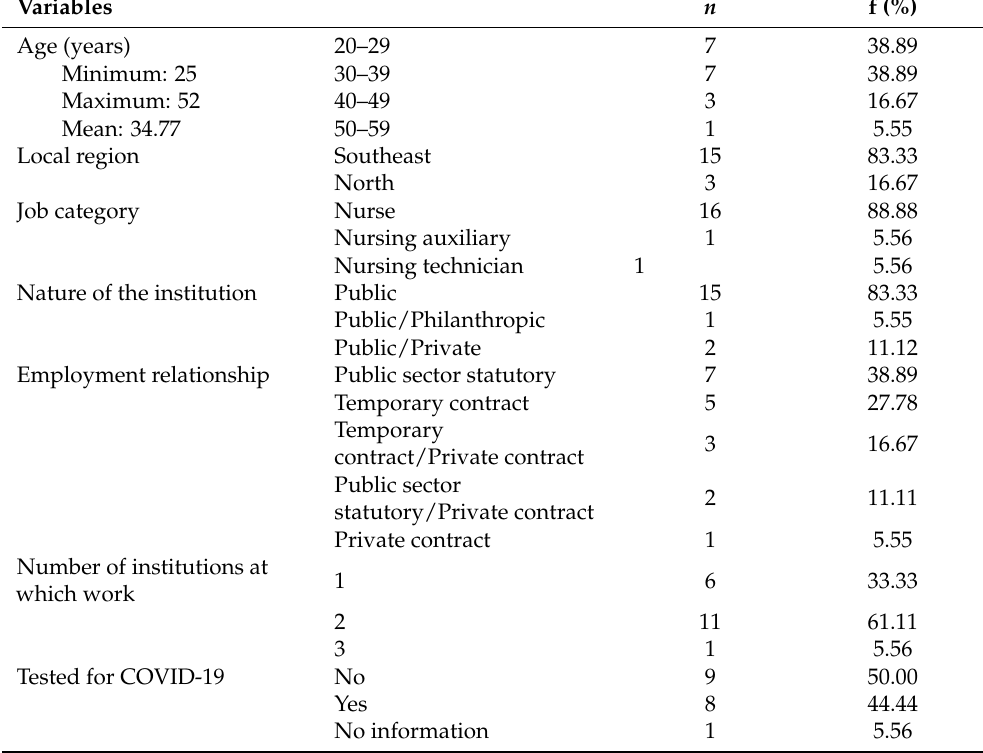
Table 1. Study participants’ sociodemographic, employment, and clinical characteristics, Rio de Janeiro, Brazil, 2020 ( n =